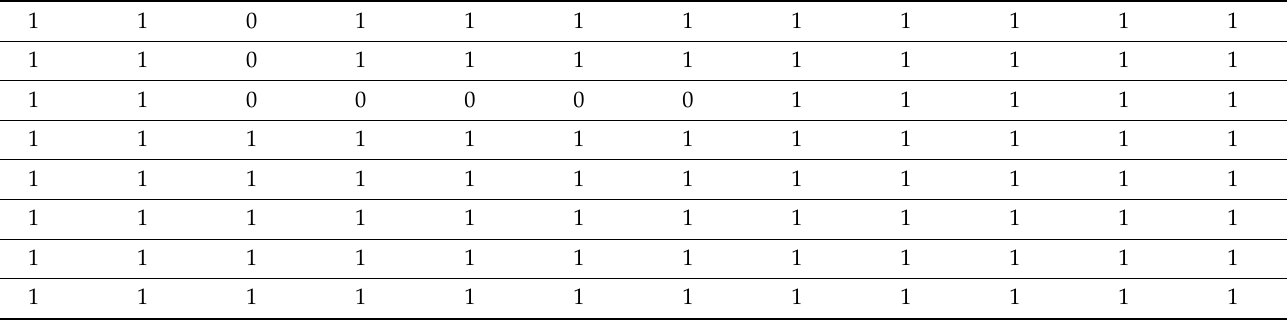
Table 7. Arr3Node array contents.